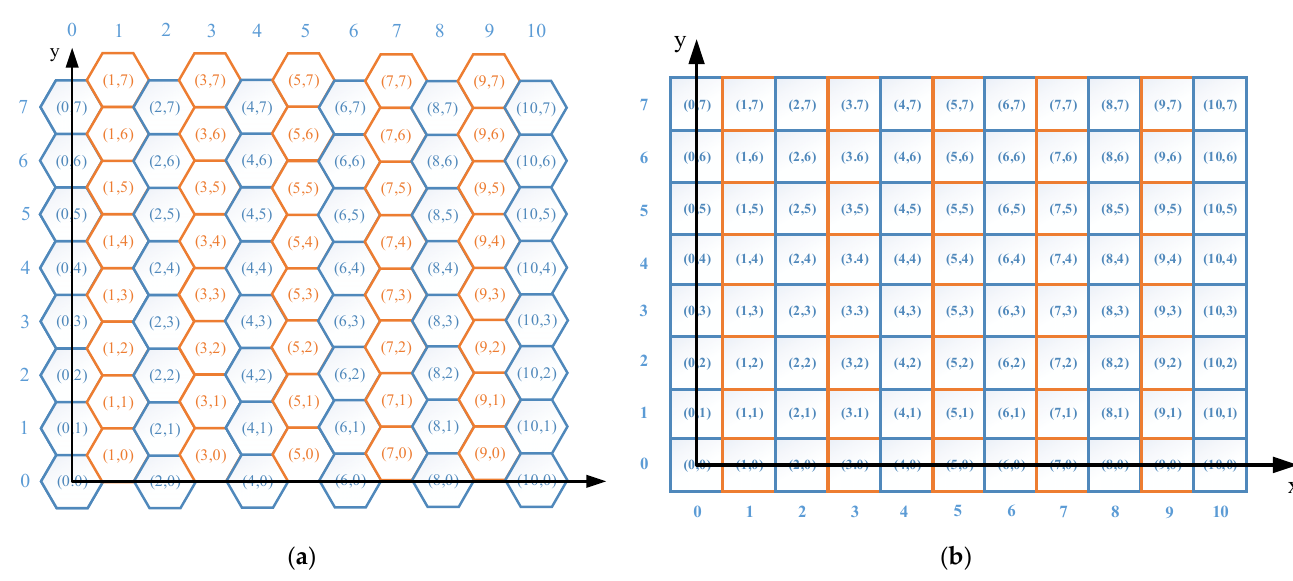
Figure 2. ( a ) Planar hexagonal grid system based on an orthogonal coordinate system; ( b ) planar quadrilateral grid system based on an orthogonal coordinate system.